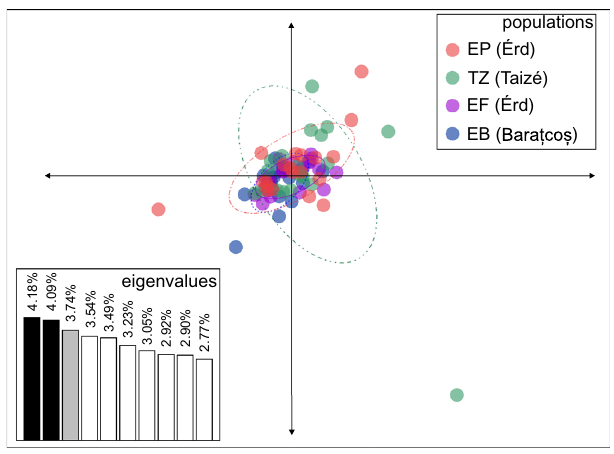
Figure 3. Principal component analysis of raw allelic frequencies of the studied Polyommatus icarus samples (populations are marked with different colors). 95% ellipses are superimposed on each population. Eigenvalues of the first ten axes are given in an inset